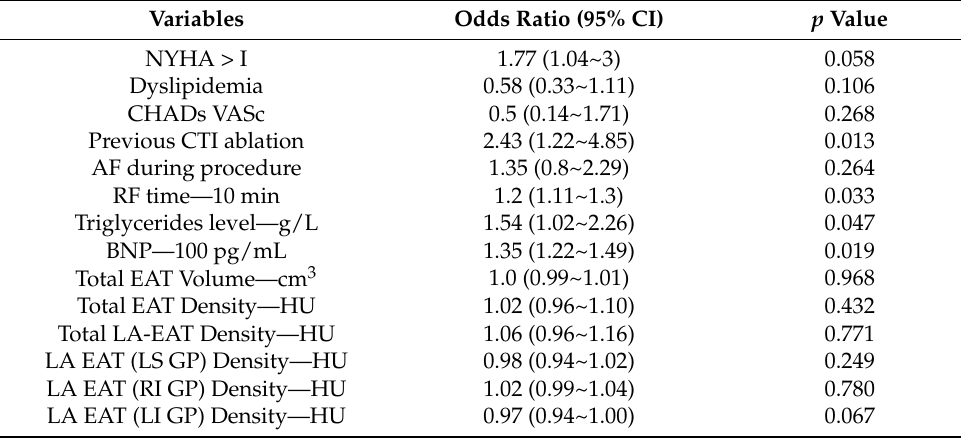
Table 3. Multivariate analysis of AF recurrence after CA after 12-months